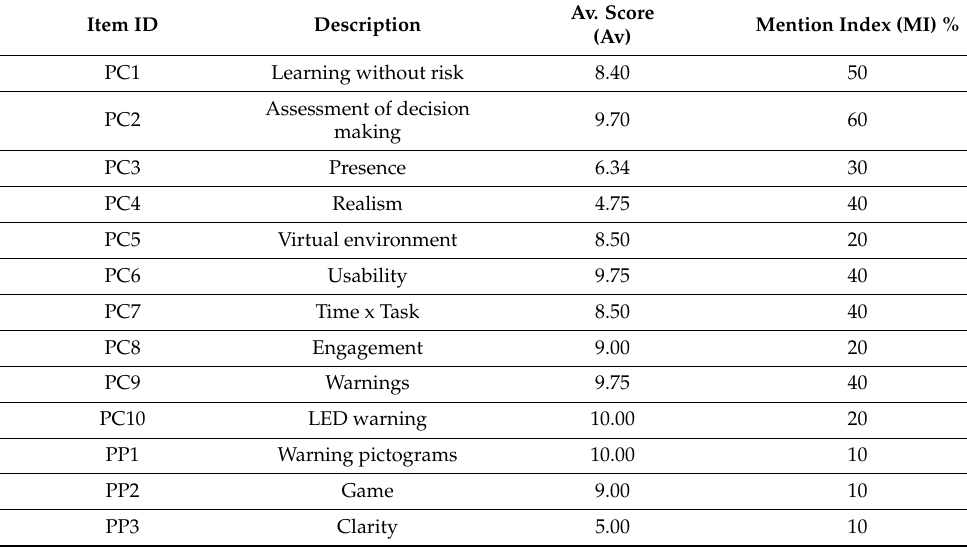
Table 3. BLA positive common (PCx), negative common (NCx), positive particular (PPx), and negative particular (NPx) elements of the game and sensor warning